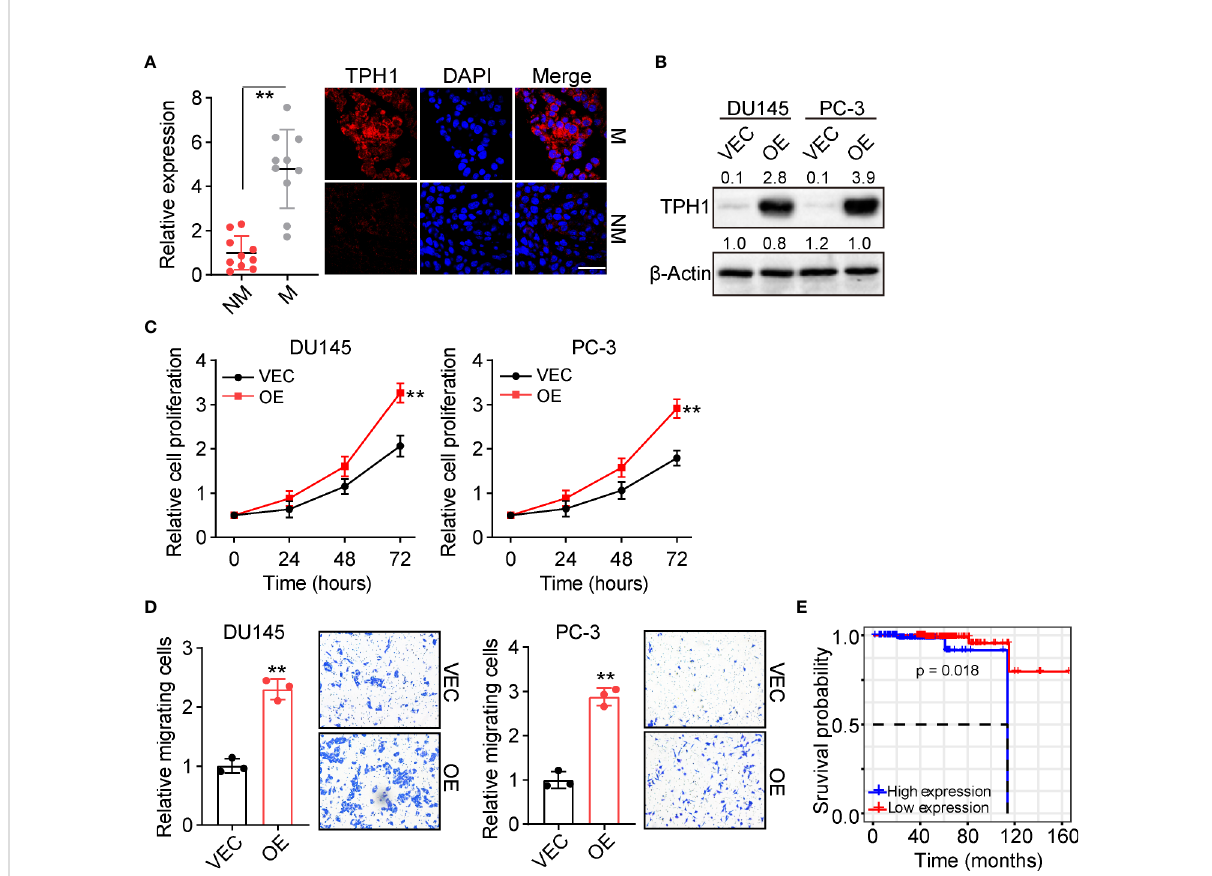
FIGURE 1 Tryptophan hydroxylase 1 (TPH1) drives prostate cancer cell proliferation and migration. (A) Immuno fl uorescence staining of TPH1 in tumor tissues from patients with metastatic (M) and nonmetastatic (NM) prostate cancer (n = 10 per group). The scale bar is 60 m m. (B) Western blotting of TPH1 in DU145/PC-3 and TPH1-overexpressing DU145/PC-3 cells. (C) Relative proliferation of DU145/PC-3 and TPH1-overexpressing DU145/PC-3 cells using the CCK-8 assay. (D) Relative number of migrating DU145/PC-3 and TPH1-overexpressing DU145/PC-3 cells determined using the transwell assay. (E) Overall survival of patients with prostate cancer divided into the high TPH1 (n = 96) and low TPH1 expression (n=150) groups. ** p <